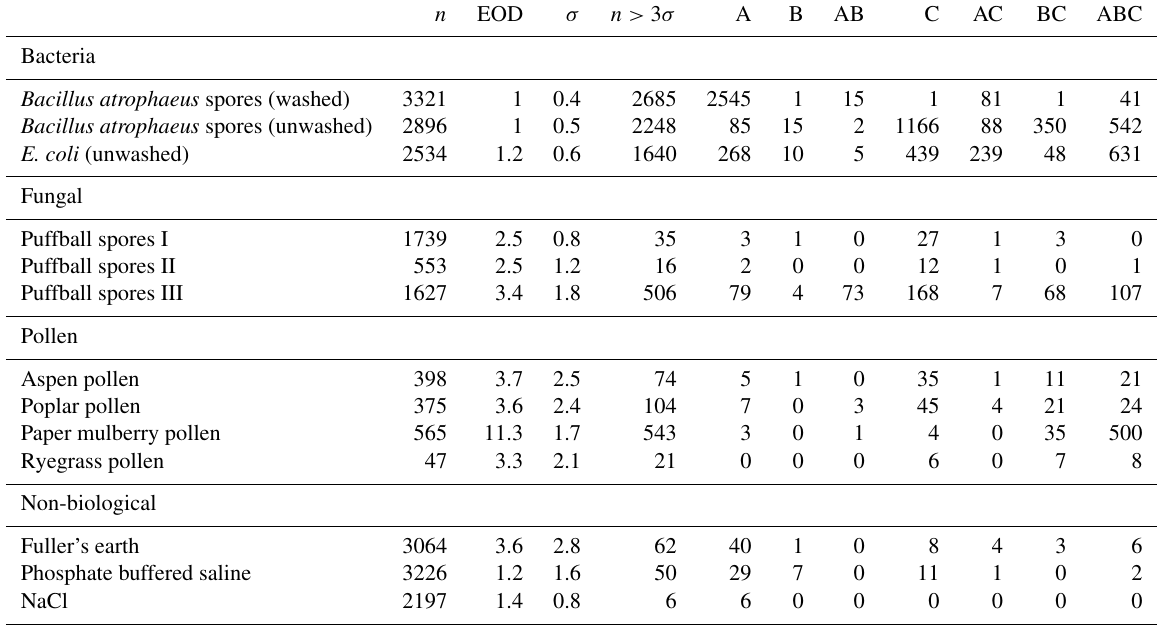
Table B2. For the data collected in 2014, a summary of size and fluorescent measurements for each sample to include: the number of particles in the sample (total), average equivalent optical diameter (EOD), standard deviation of the size ( σ ), the number of points that exceeded